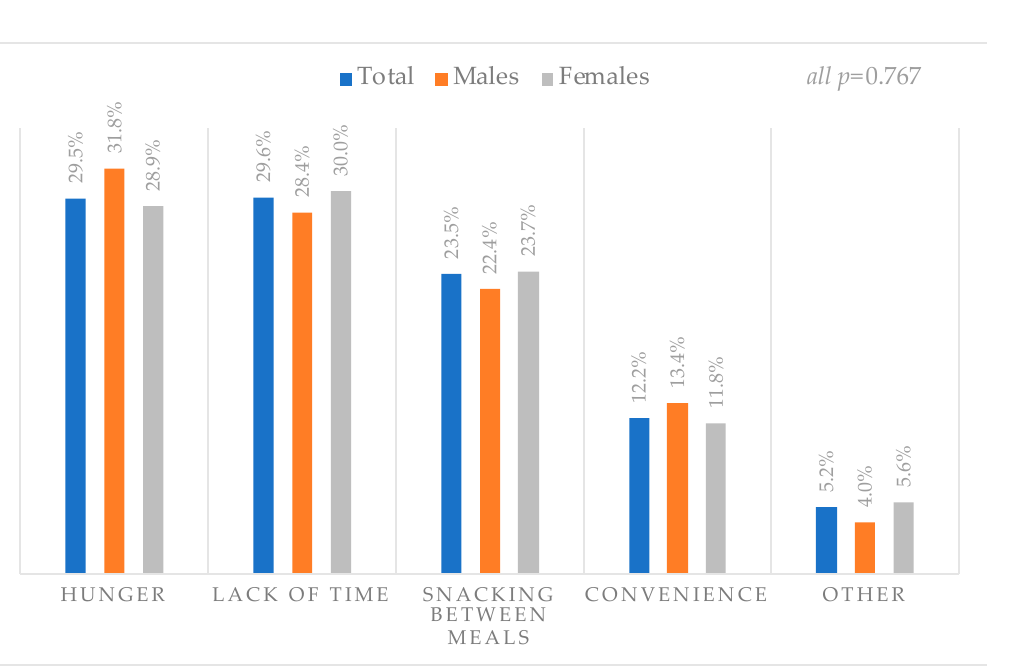
Table 3. Opinions of the study participants about vending machine food items ( n = 1250).